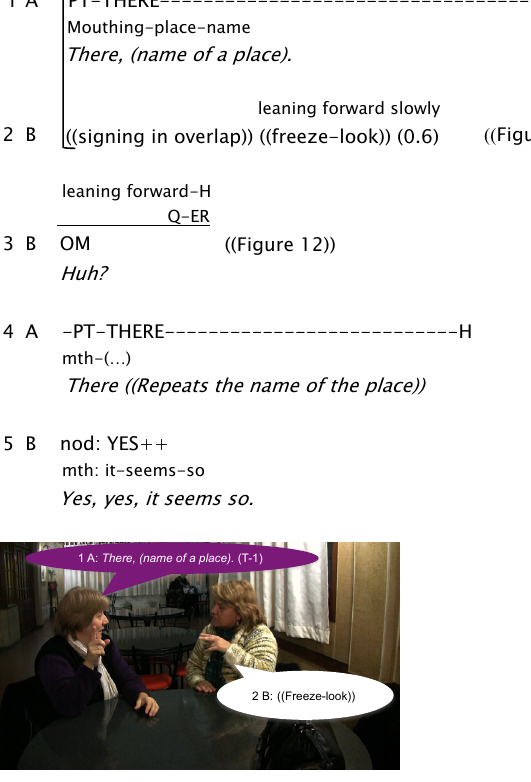
Figure 11. Person B, on the right, performs a freeze-look before the explicit initiation of repair (line2).